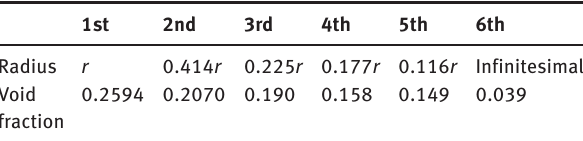
Table 1: Parameters of the Horsfield filling